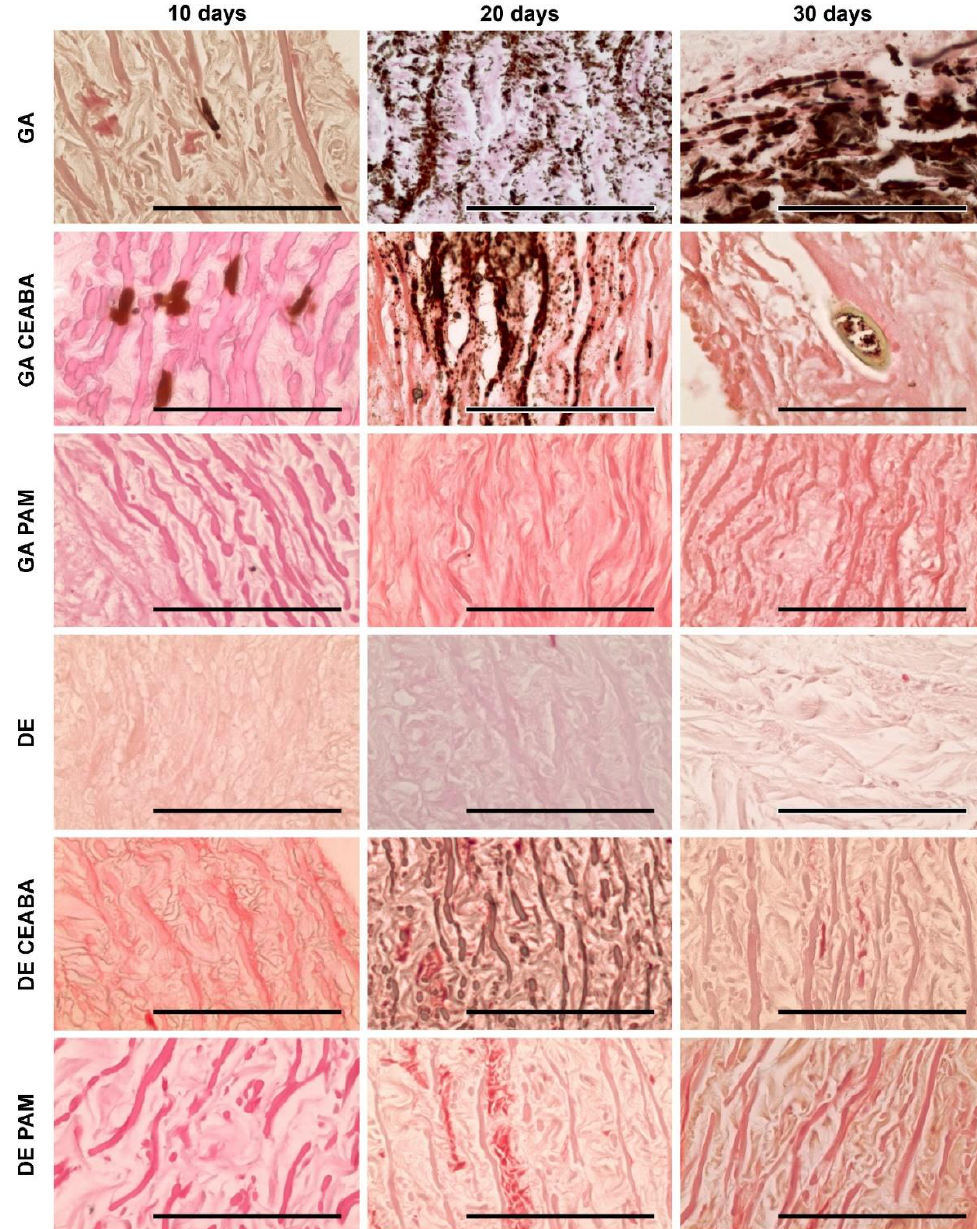
Figure 7. Calcium phosphate deposits in bovine jugular vein wall implanted subcutaneously in rats, as visualized by von Kossa staining. Calcium phosphates were observed in GA- and (GA + CEABA)- treated samples. Deposits are stained from light to dark brown and were localized predominantly along the elastin fibers or as dust-like particles in collagen. Large conglomerates of calcium phos- phates were observed in GA-treated samples on day 30 after implantation. All DE- and (GA + PAM)- treated samples were free of calcific deposits. Scale bars: 100 μm.